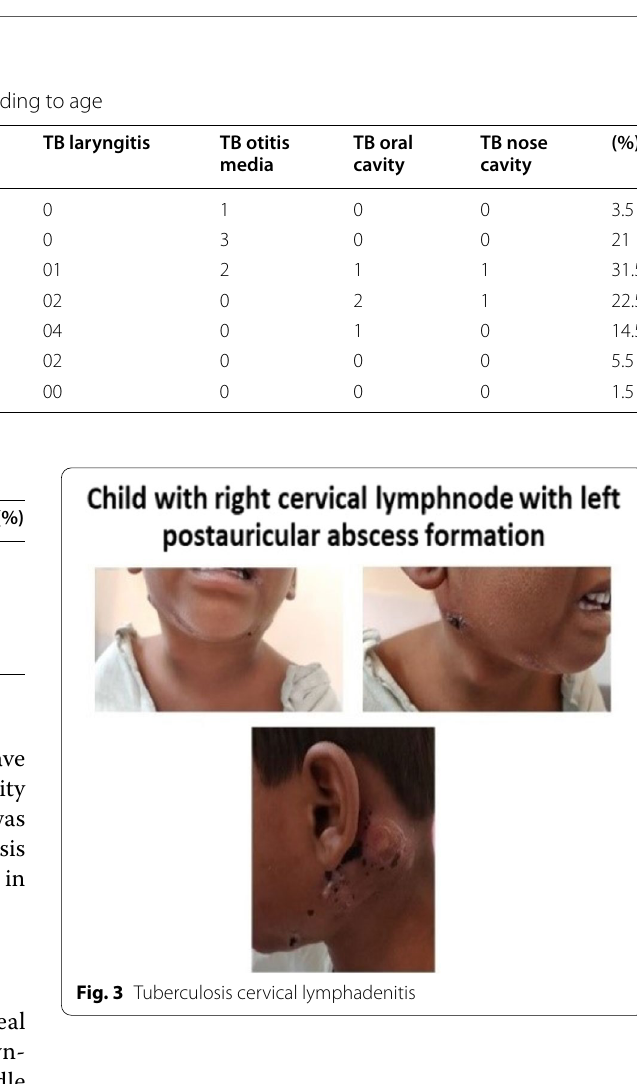
Fig. 2 Sex ratio of tuberculosis in ENT and neck region